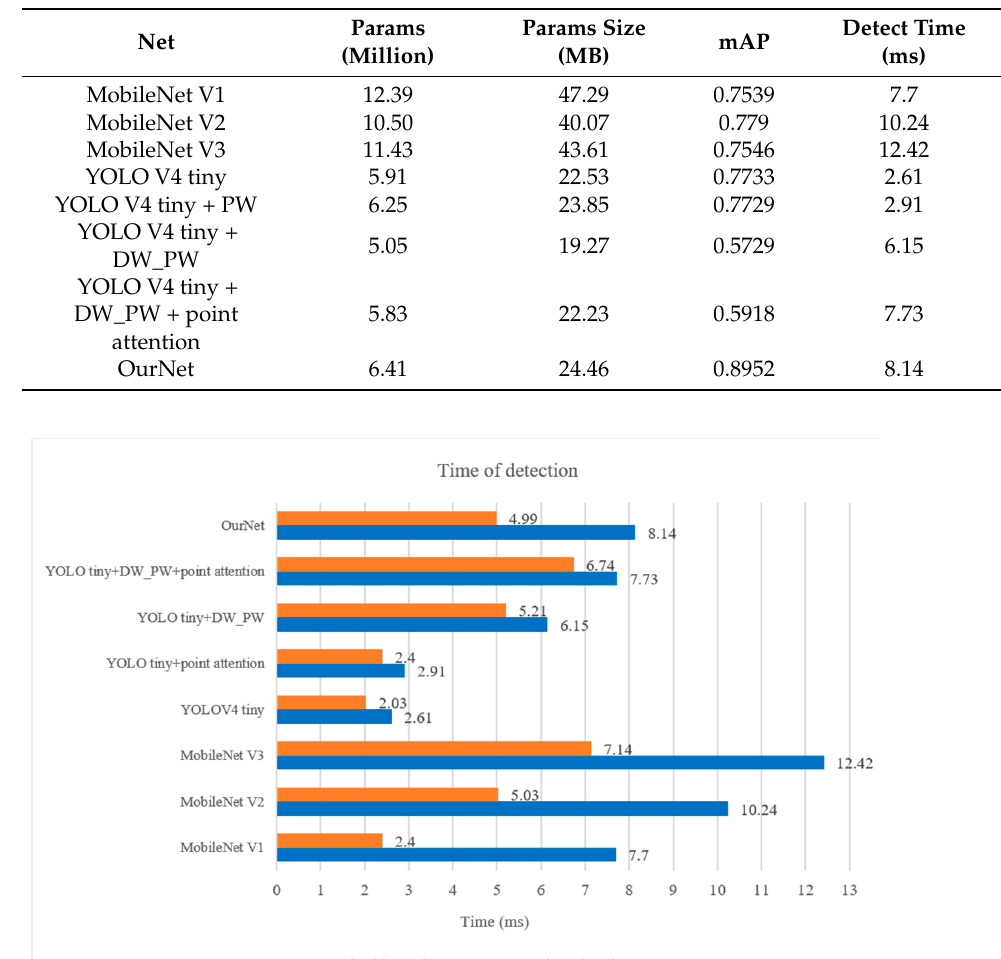
Table 2. Parameters, performance indicators, and response time of different models.